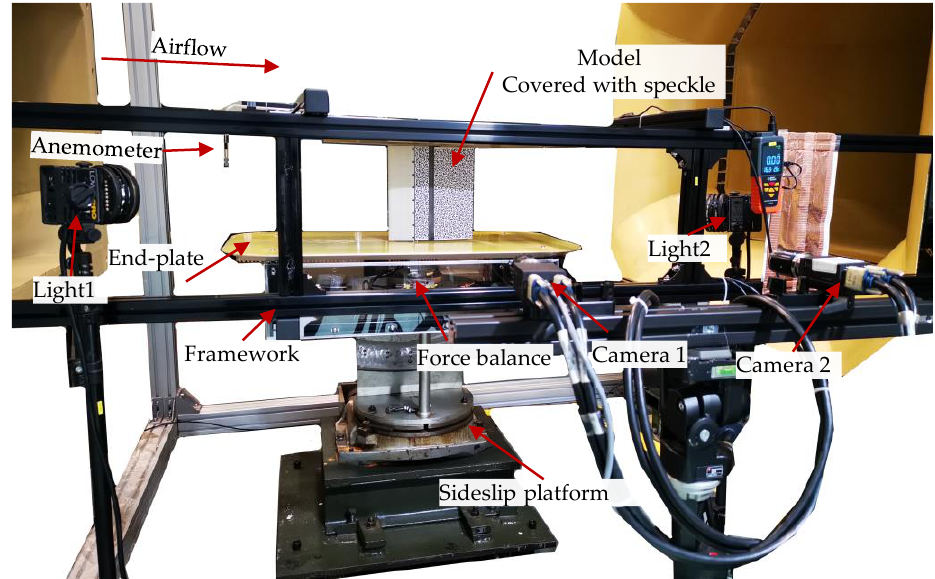
Figure 18. An overview of the wind tunnel equipped with test platform and morphing wing model.